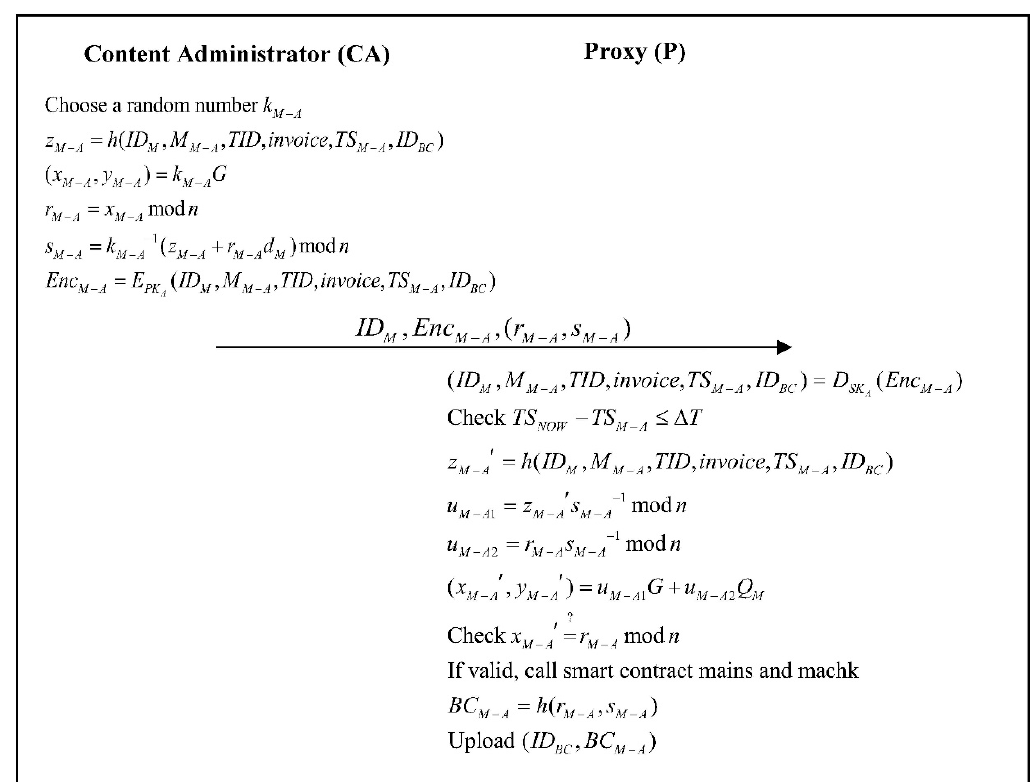
Figure 9. Authentication and issuing invoice phase (CA to P).